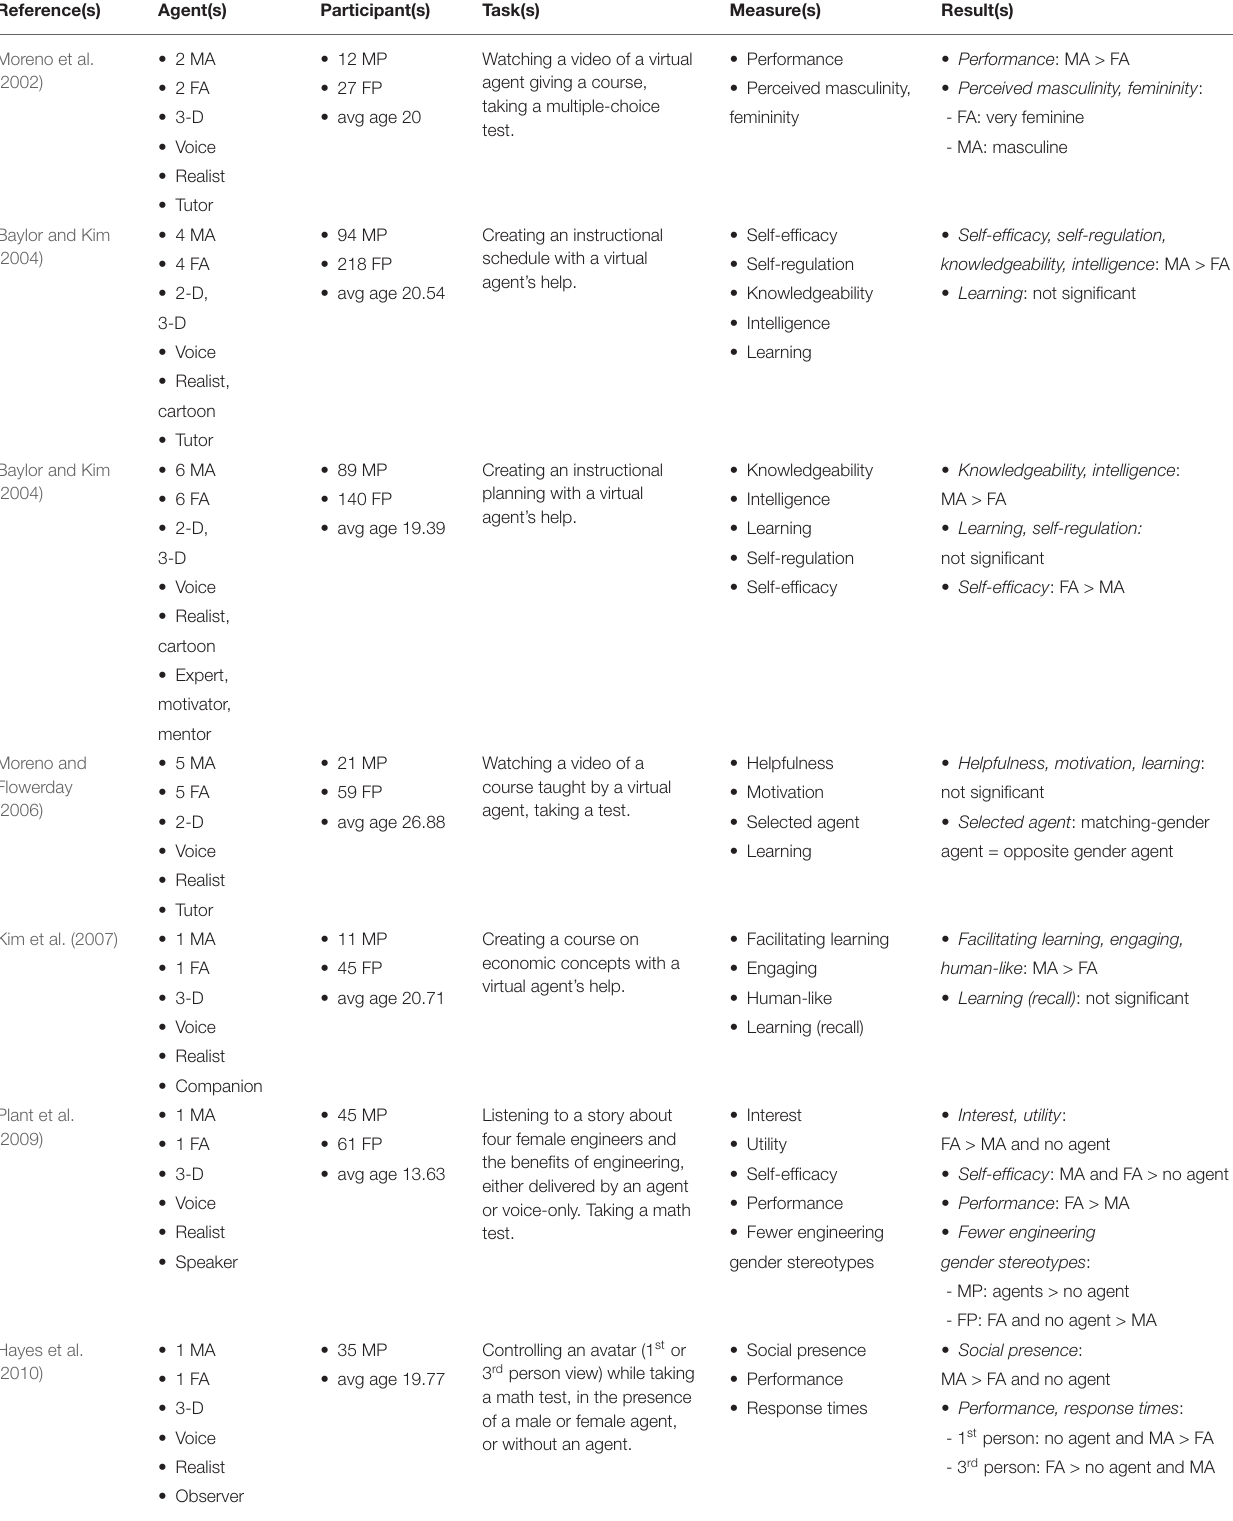
TABLE 2 | Summary of research studies on the impact of gendered virtual agents in the context of a learning task.